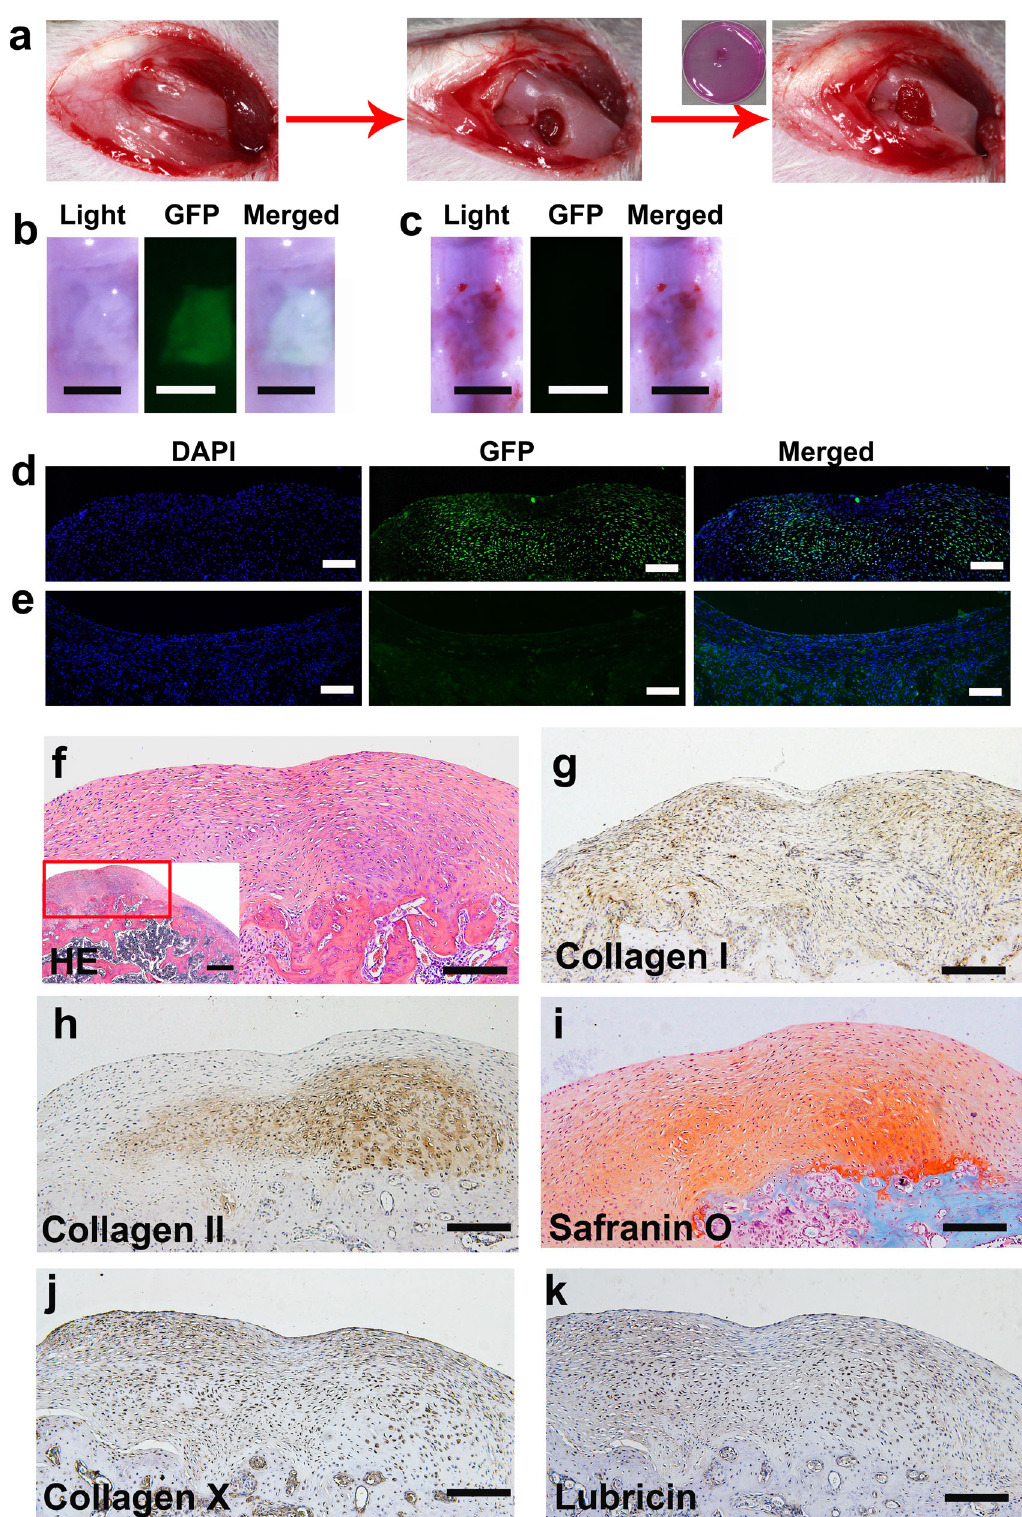
fl uorescent protein (GFP) expression was positive in the trans- planted site 4 weeks later (Fig. 6d). Accordingly, no GFP was detected in the control group (Fig. 6e). Mature TMJ condylar cartilage consists of the following four zones (Supplementary Fig. 10a) 16 , which are different from knee